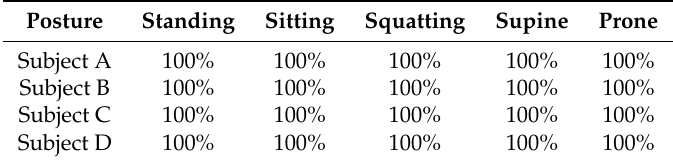
Figure 12. The five postures of proposed posture recognition algorithm. ( a ) Standing posture; ( b ) Sitting posture; ( c ) Squatting posture; ( d ) Supine posture.; ( e ) Prone posture. Table 2. The results of posture